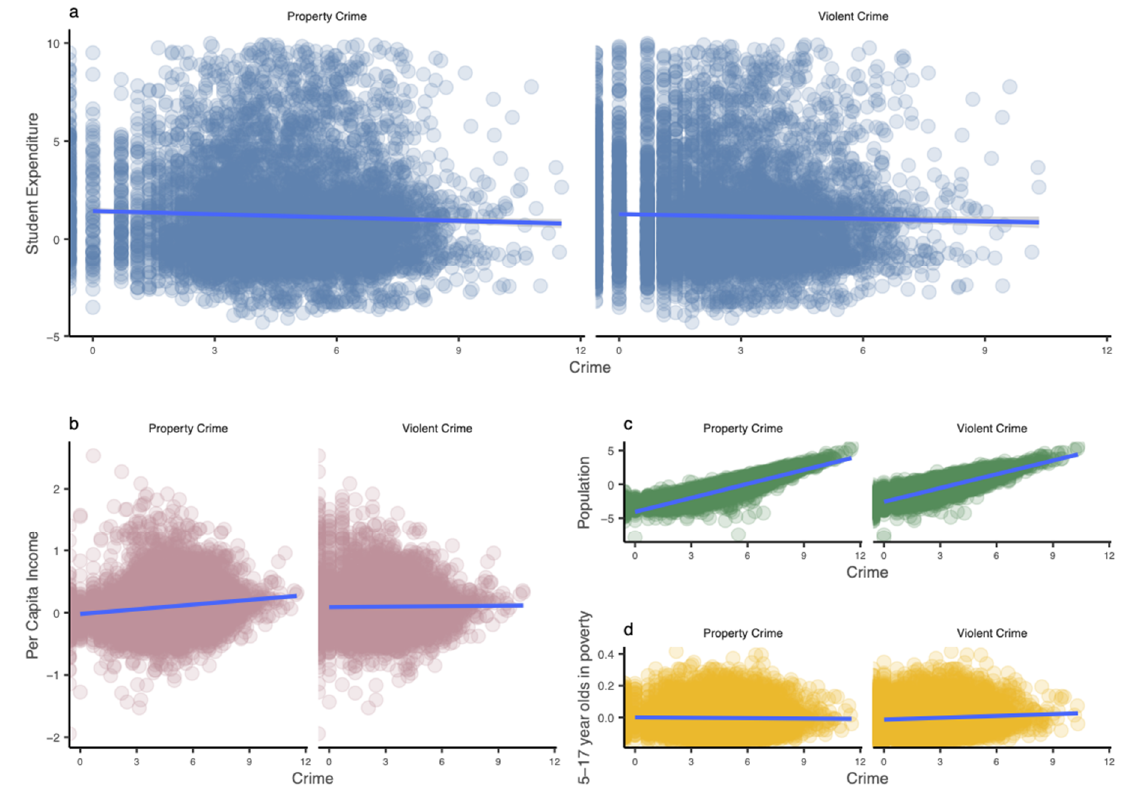
Figure 3. 2017 crime statistics plotted by expenditure, per capita income, population, and proportion 5–17 year-olds in poverty. All values are centered. Per capita income, population, and crime are log transformed. On average, crime increases with decreased education spending and increasing population. Importantly, property crime increases with wealth (per capita income) and violent crime decreases, demonstrating an important interaction that one must control for.